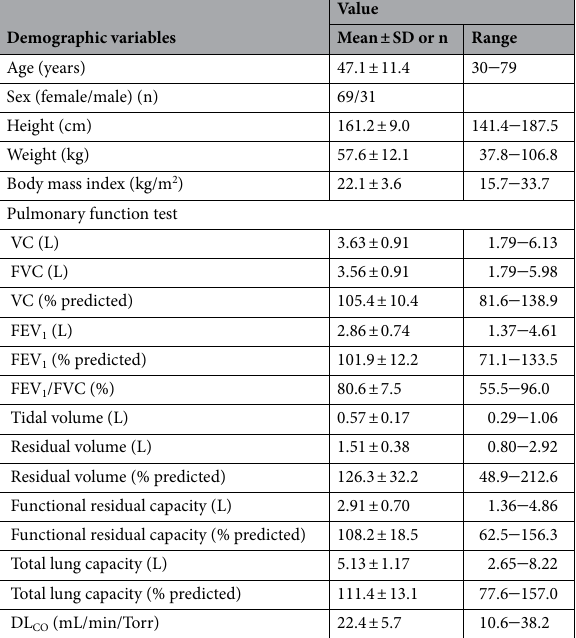
Table 1. Characteristics of the study population (100 volunteers). SD, standard deviation; FEV 1 , forced expiratory volume in 1 s; FVC, forced vital capacity; VC, vital capacity; DL CO , diffusing capacity of the lung for carbon